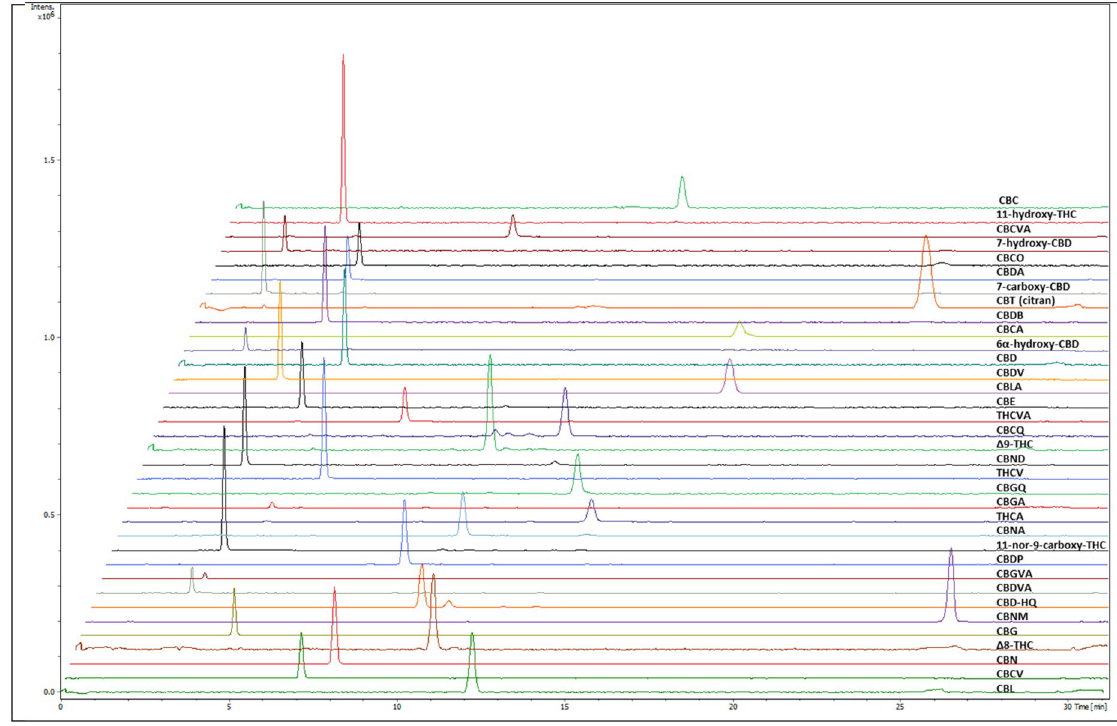
Figure 1. Optimised separation of 35 commercially available cannabinoids by UHPLC-TIMS-TOF-MS. From top to bottom: cannabichromene (CBC), 11-hydroxy-Δ9-tetrahydrocannabinol (11-OH-Δ9-THC), cannabichromevarinic acid (CBCVA), 7-hydroxy-cannabidiol (7-hydroxy-CBD), cannabichromeorcin (CBCO), cannabidiolic acid (CBDA), 7-carboxy-cannabidiol (7-COOH-CBD), cannabicitran (CBT), cannabidibutol (CBDB), cannabichromenic acid (CBCA), 6-α-hydroxy-cannabidiol (6-α-OH-CBD), cannabidiol (CBD), cannabidivarin (CBDV), cannabicyclolic acid (CBLA), cannabielsoin (CBE), tetrahydrocannabivarinic acid (THCVA), cannabichromenquinone (CBCQ), Δ9-tetrahydrocannabinol (Δ9-THC), cannabinodiol (CBND), tetrahydrocannabivarin (THCV), cannabigeroquinone (CBGQ), cannabigerolic acid (CBGA), Δ9-tetrahydrocannabinolic acid A (THCA), cannabinolic acid (CBNA), ( −)-11-nor-9-carboxy-Δ9-THC (11-COOH-Δ9-THC), cannabidiphorol (CBDP), cannabigerovarinic acid (CBGVA), cannabidivarinic acid (CBDVA), cannabidiol hydroxyquinone (CBD-HQ/HU-331), cannabinolmonomethlyether (CBNM), cannabigerol (CBG), Δ8-tetrahydrocannabinol (Δ8-THC), cannabinol (CBN), cannabichromevarin (CBCV) and cannabicyclol